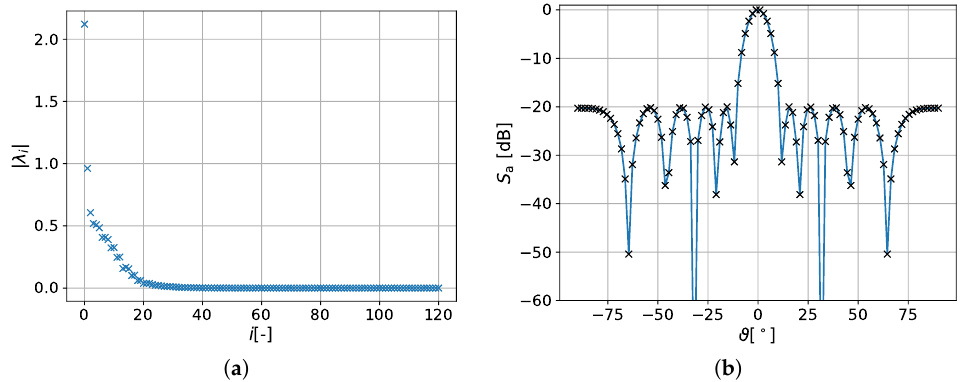
Figure 5. Order reduction and pseudo-inverse. ( a ) Eigenvalues of transformation matrix; ( b ) Compar- ison of array factor calculated from excitation obtained by direct usage of Dolph–Chebychev method and reconstructed by